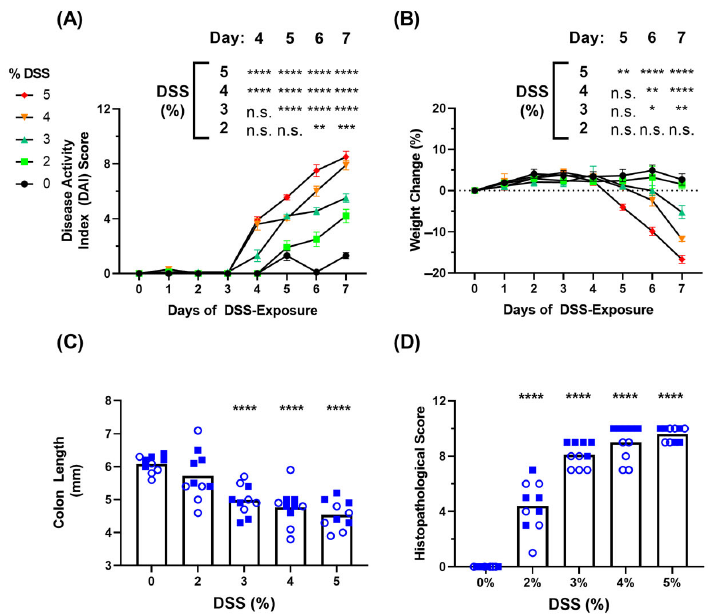
Figure 1. Clinical signs of disease within the acute, DSS ‐ mediated experimental colitis model. C57BL/6 mice (n = 10/group) were exposed to dextran sulphate sodium (DSS) within drinking water (0–5% m / v ) for a period of 7 days. The Disease Activity Index (DAI) (Panel ( A )) and Body Weight Change (%) (Panel ( B )) for each of the groups during the course of DSS treatment is shown. At the end of the study period, the colons were examined for their length (Panel ( C )) before being fixed, H&E stained and analyzed for a Histopathological Score (Panel ( D )). Grouped data is presented as mean + standard error of mean (SEM). In panels ( C , D ), empty circles and filled squares represent female and male mice, respectively. Statistical significance of differences are compared relative to the control (0% DSS) group and are shown as *: p < 0.05, **: p < 0.01, ***: p < 0.001, ****: p < 0.0001 by two ‐ way ANOVA followed by Šidák’s (Panel ( A )) or Dunnett’s (Panel ( B )) multiple comparisons